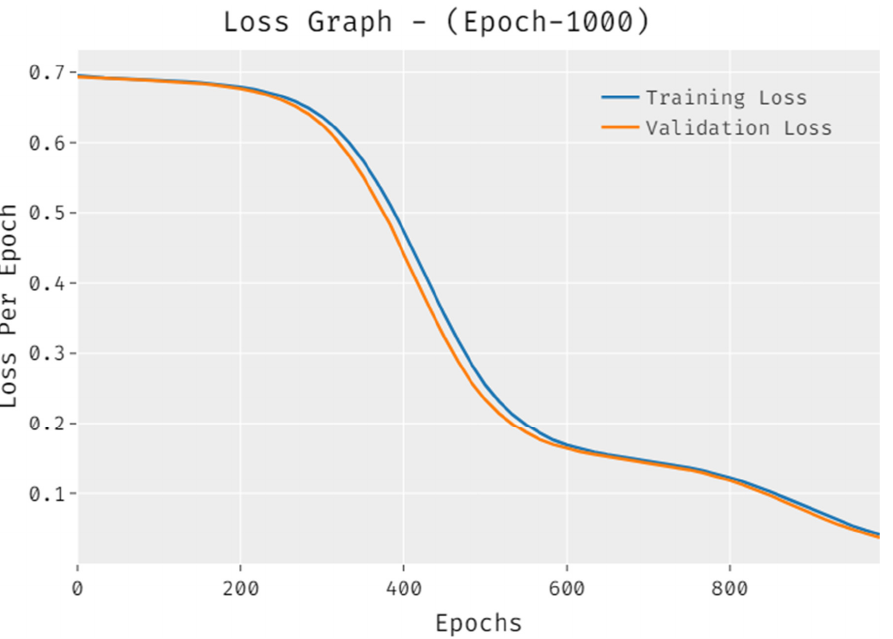
Figure 7. Accuracy graph analysis of DLSODC ‐ GWM technique under 1000 epochs.